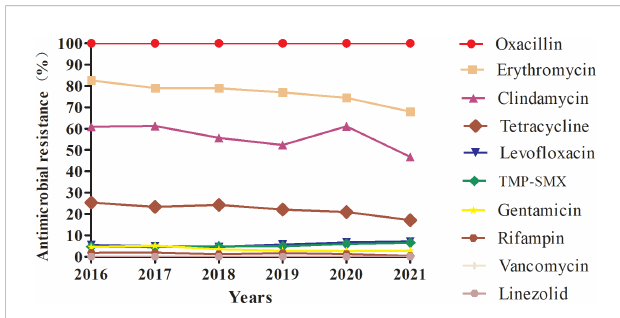
FIGURE 2 Pro fi le of resistance to ten main antimicrobials (%) of MRSA isolates collected from 2016 to